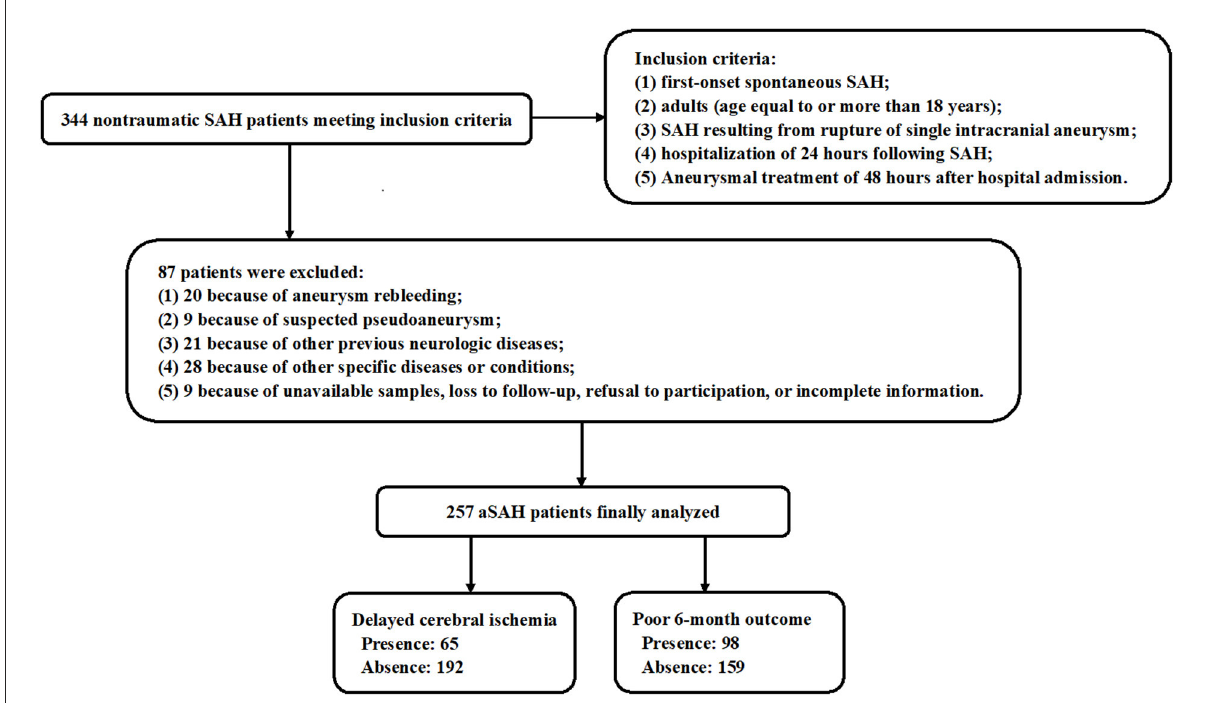
FIGURE1 Flow chart for screening patients with aneurysmal subarachnoid hemorrhage. A total of 344 patients with spontaneous aneurysmal subarachnoid hemorrhage obtained an initial assessment according to the inclusion criteria, then 87 patients were removed from this study based on the exclusion criteria, and finally, 257 patients were retained for further analysis. aSAH, aneurysmal subarachnoid hemorrhage.